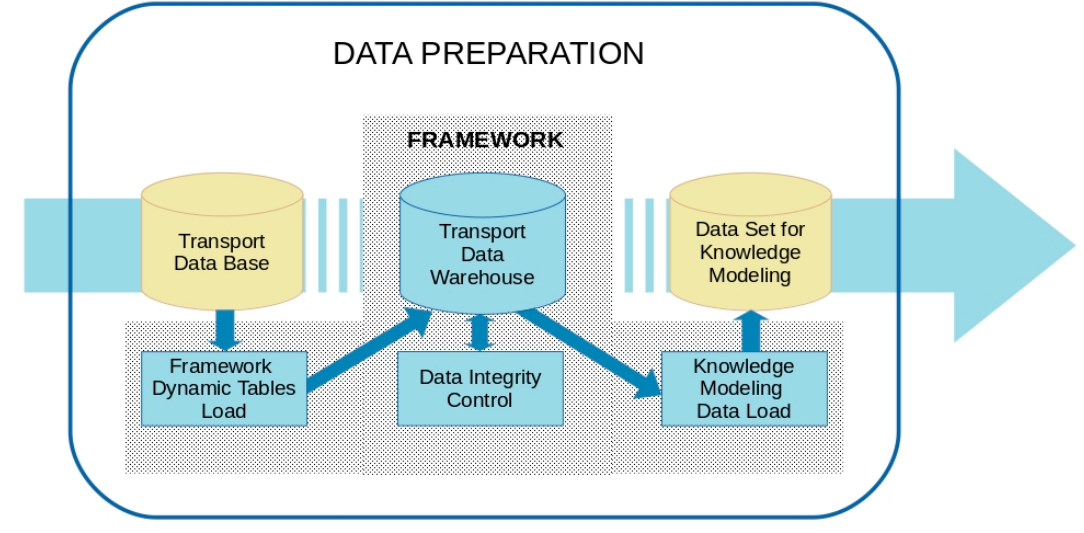
Figure 3. Framework general